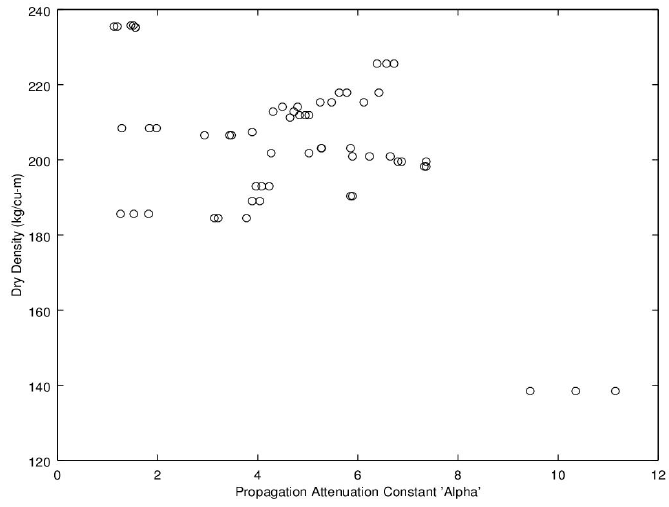
Figure 12. Propagation attenuation constant, α , versus bulk dry density (no water) at 2.5 GHz.